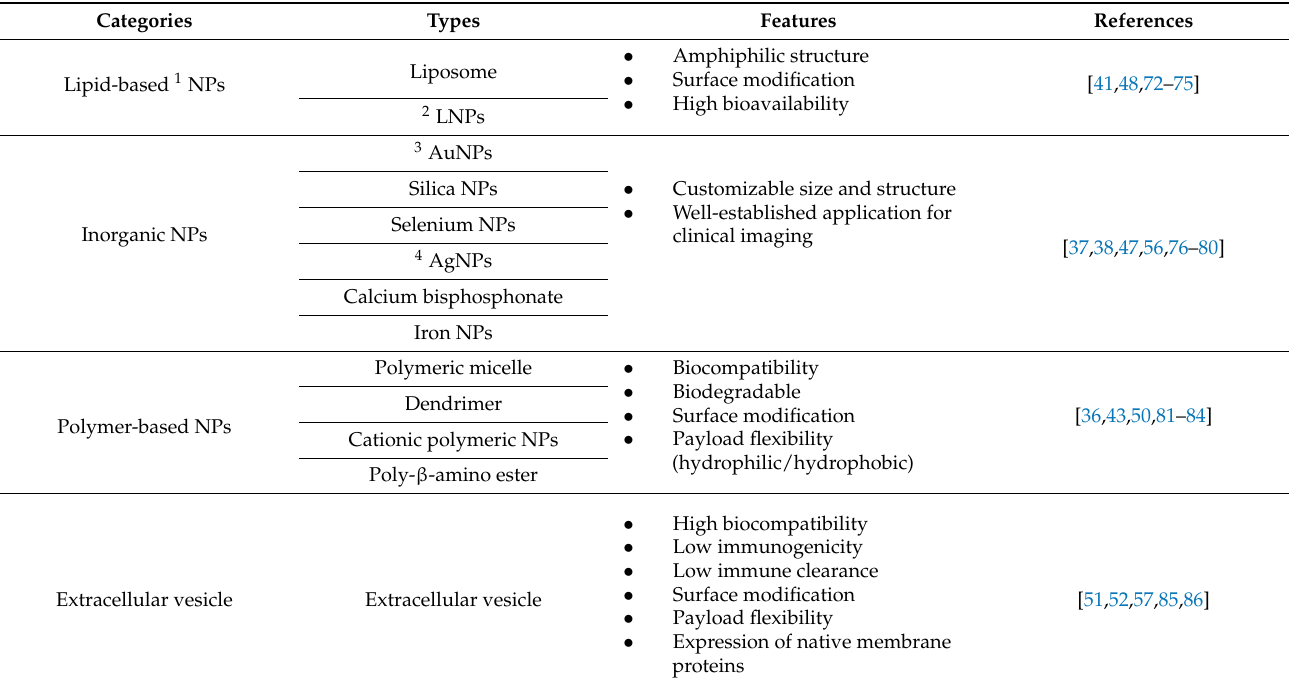
Table 1. Different types of nanoparticles and their properties as a delivery molecule.